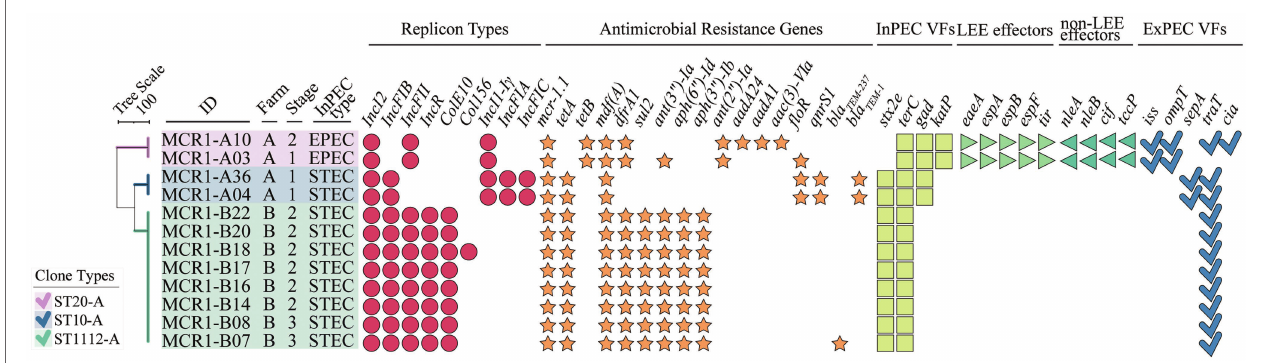
FIGURE 5 | Whole-genome sequence (WGS)-based in-depth genetic characterization of 12 intestinal pathogenic MCR1-EC strains. The phylogenetic tree was constructed based on allele profiles of multi-locus sequence types (MLSTs) of 12 intestinal pathogenic MCR1-EC strains via the Unweighted Pair Group Method with Arithmetic means (UPGMA) method, calculating dice coefficients in the Bionumerics program (v6.6). Visualization was conducted using the online visualization tool iTOL (v6, https://itol.embl.de/). MCR1-EC, Escherichia coli carrying the mobilized colistin resistance gene mcr-1.1 ; Stage 1, weaning piglets; Stage 2, growing pigs; Stage 3, finishing pigs; Stage 4, pregnant sows; InPEC type, intestinal pathogenic E. coli type; EPEC, enteropathogenic E. coli ; STEC, shiga toxin-producing E. coli ; InPEC VFs, intestinal pathogenic E. coli -associated virulence factors; LEE effectors, locus of enterocyte effacement (LEE)-encoded effectors; non-LEE effectors, non-LEE-encoded effectors; and ExPEC VFs, extra-intestinal pathogenic E. coli -associated virulence